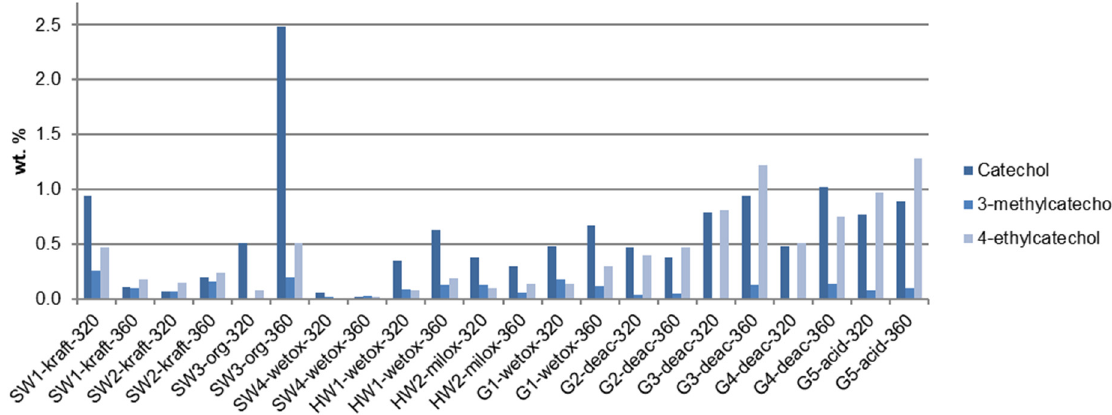
Figure 4. Quantification of guaiacol and selected substituted guaiacols in the produced bio-oils, given as wt.% in the obtained bio-oil. Sample names are specified in the experimental section.